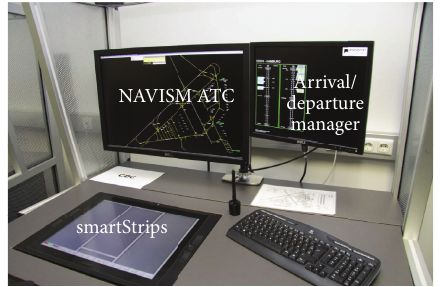
Figure 11: One of the five controller working positions.